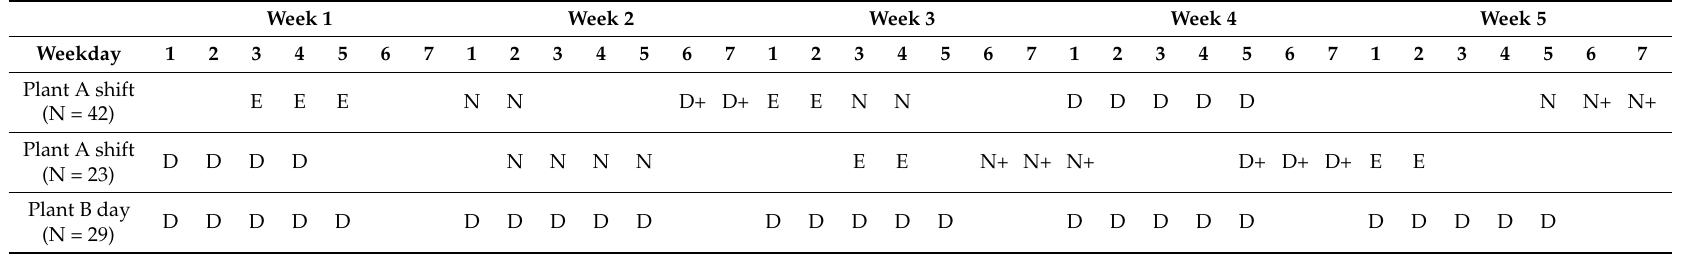
Table 2. The current 5-week shift plan for Plant A and B. E: Evening shift lasting 8 h, N: Night shift lasting 8 h (N+ = 12 h), D: Dayshift lasting 8 h (D+ =12 h); The working hours for D are 7 a.m. to 3 p.m., D+ are 7 a.m.to 7 p.m., A are 3 p.m. to 11 p.m., N are 11 p.m. to 7 a.m. and N+ are 7 p.m. is 7